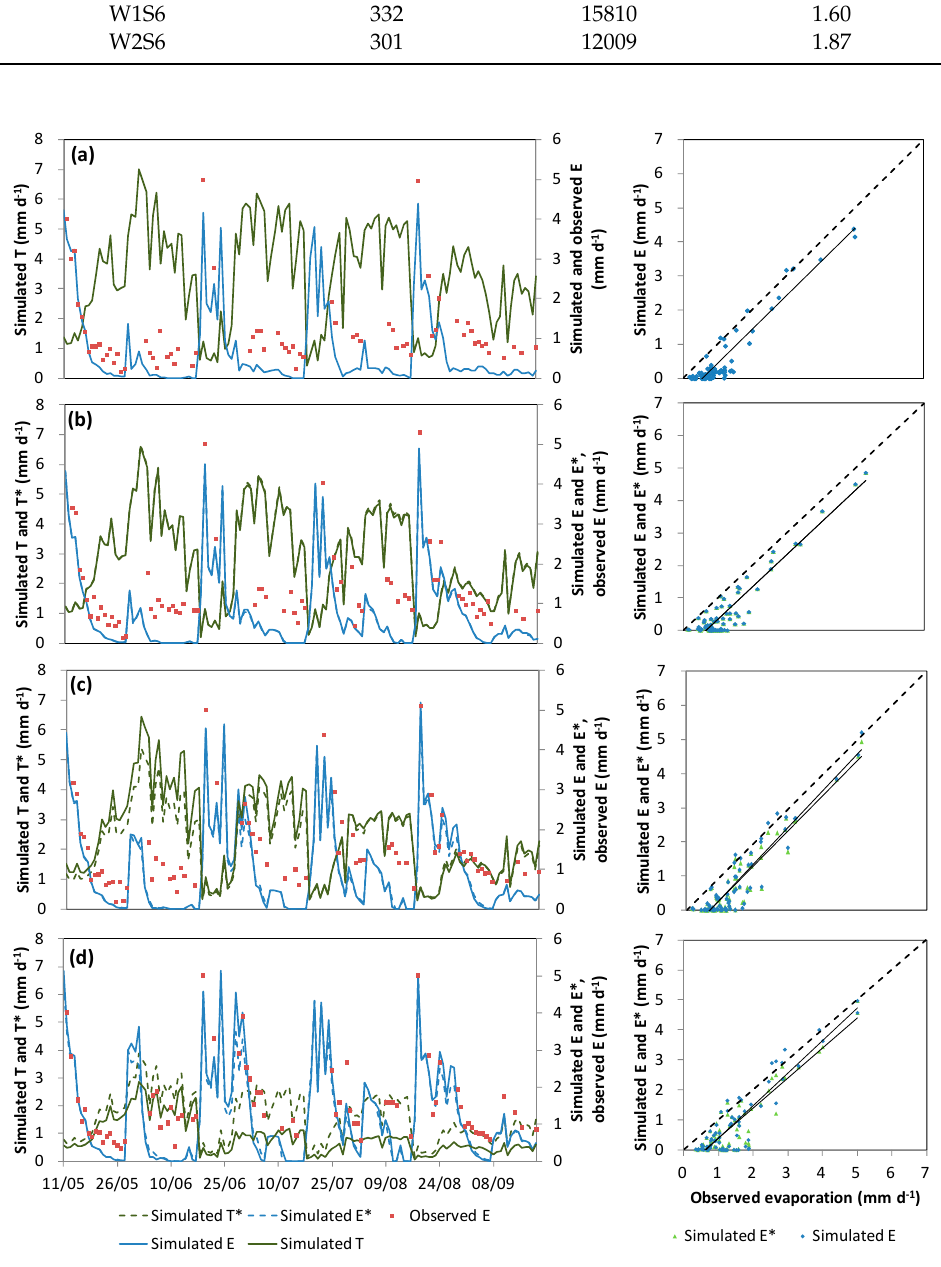
Figure 6. Simulated crop transpiration ( T ), soil evaporation ( E ) and observed E for the alfalfa were shown during the whole growth period of alfalfa in 2019: ( a ) W1S0, ( b ) W2S2, ( c ) W2S4 and ( d ) W2S6. The simulations with a constant yield response factor ( K y = 1.2) were shown by solid lines and dynamic K y by dotted lines.